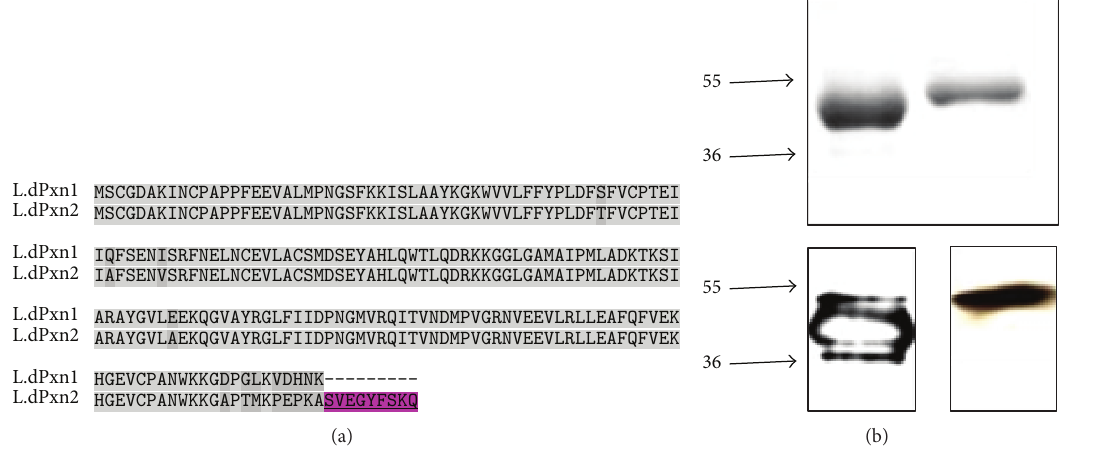
Figure 1: (a) Sequence comparison of Leishmania donovani Pxn1 and Pxn2. Alignment of amino acid sequence depicts the high homology between LdPxn1 and LdPxn2. Highlighted areas show positions of mismatch. LdPxn2 possesses extra 9 amino acids at the carboxy terminus (underlined) that are missing from LdPxn1. (b) SDS-PAGE and western blot of rLdPxn1 and rLdPxn2 proteins. One microgram per lane of rLdPxn1 (lane 1) and rLdPxn2 (lane 2) was separated on a 12% SDS-PAGE and stained with Coomassie blue, top. The separated samples were transferred to Hybond-P membrane and were probed with pooled sera from mice immunized with the respective recombinant protein, bottom. Molecular weight in kDa is shown on the